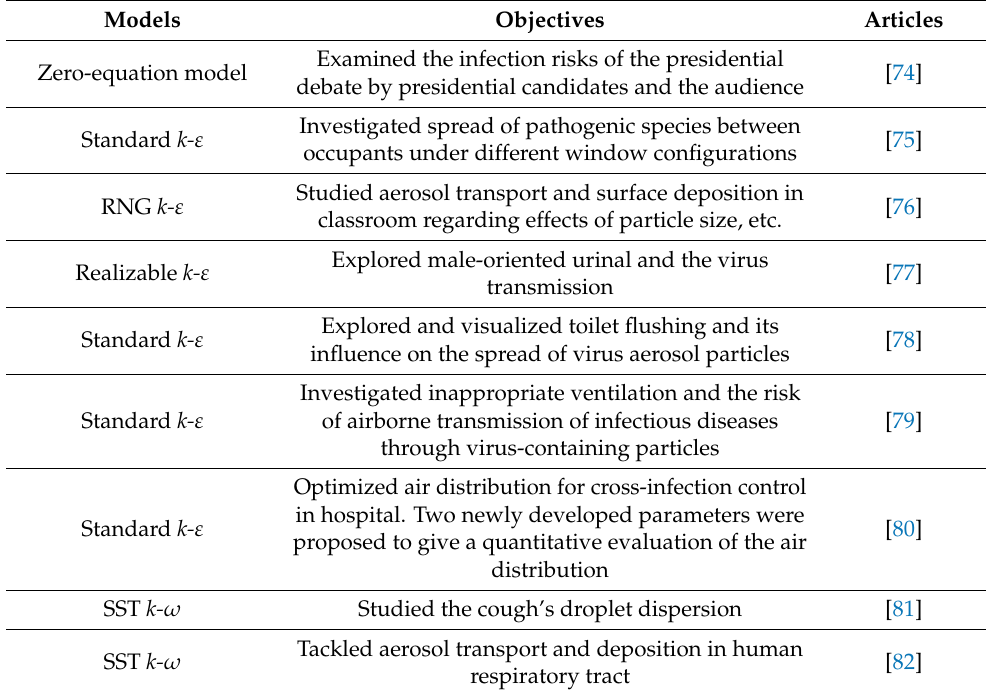
Table 3. Application of RANS models in modeling COVID-19 virus transmission research.